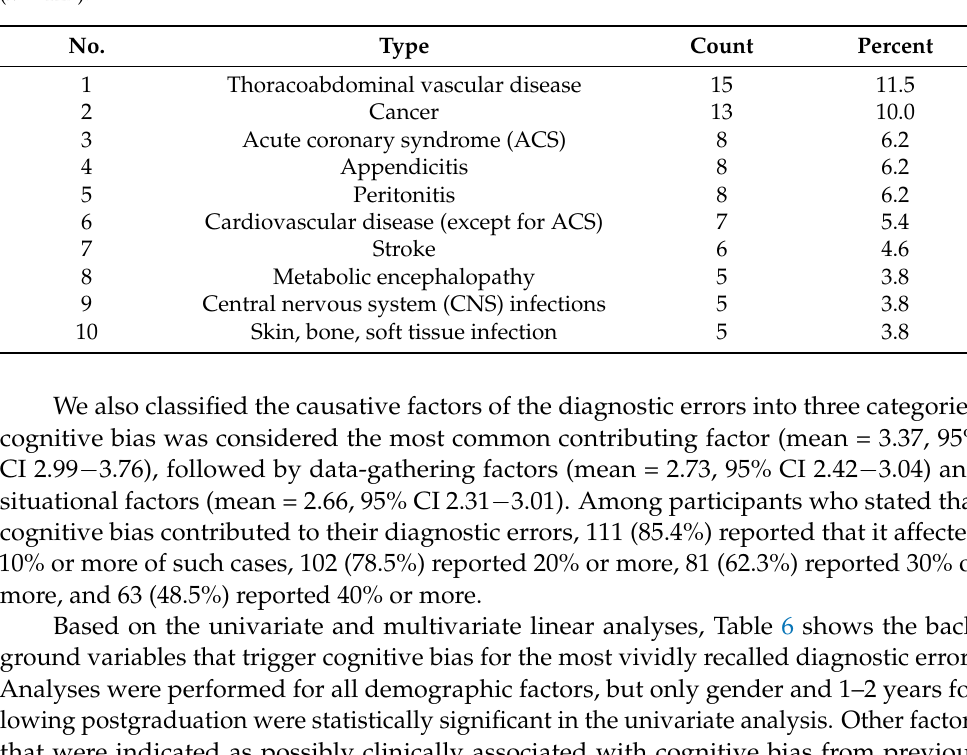
Table 5. Top 10 final diagnoses among all the most memorable diagnostic error cases collected ( n =